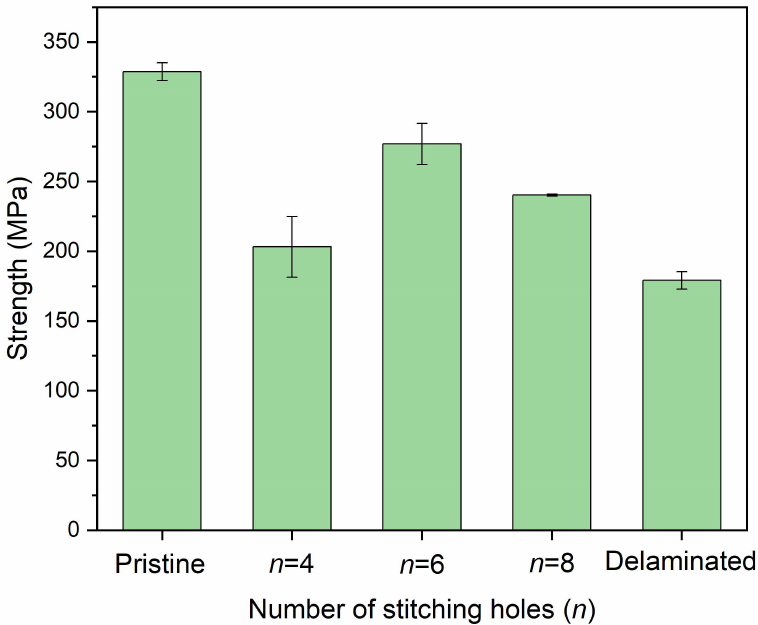
Figure 14. In-plane compressive strength of delaminated plates after stitching repair with different numbers of stitching holes in which w = 0.8 and a 2.5 mm diameter were